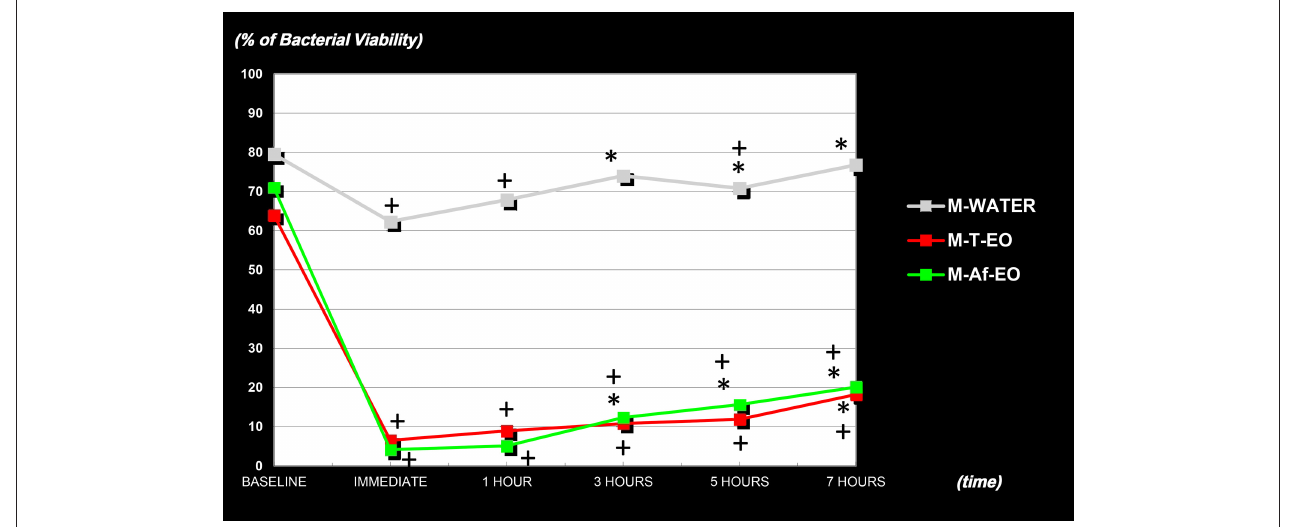
FIGURE 2 | Percentages of bacterial viability of the PL-biofilm in baseline conditions, at 30s, 1, 3, 5, and 7h after a single mouthwash with sterile water (M-WATER), with essential oils with alcohol (M-T-EO), and with essential oils without alcohol (M-Af-EO). *Statistically significant differences in regard to the 30-s sample ( P < 0.003). + Statistically significant differences in regard to the baseline ( P <